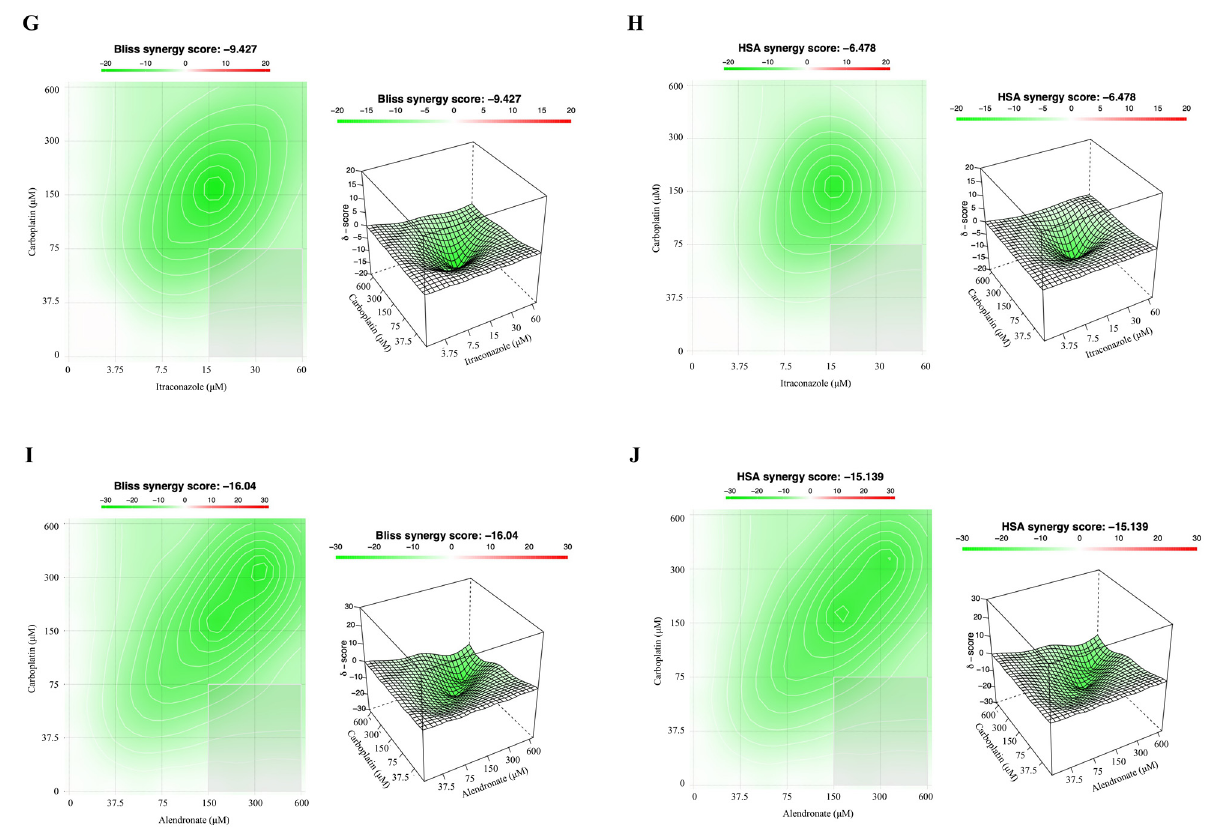
Figure 7. Combining Carboplatin with repurposed drugs has an antagonistic effect on HOSE6.3 cells. ( A – J ) Bliss Independence and High Single Agent (HSA) synergy 2D and 3D plots showing drug synergism of HOSE6.3 cells, after exposure to fixed dose ratios that correspond to 0.25, 0.5, 1, 2 and 4 fold the individual IC 50 values of each drug, e.g., Carboplatin combined with ( A , B ) Pitavastatin, ( C , D ) Metformin, ( E , F ) Ivermectin, ( G , H ) Itraconazole and ( I , J ) Alendronate for 48 h. The combined treatment was co-administered at the same time. All assays were performed in triplicate in at least three independent experiments. Synergy score: < − 10 (antagonism, green), − 10 to 10 (additivity, white) and >10 (synergism, red).